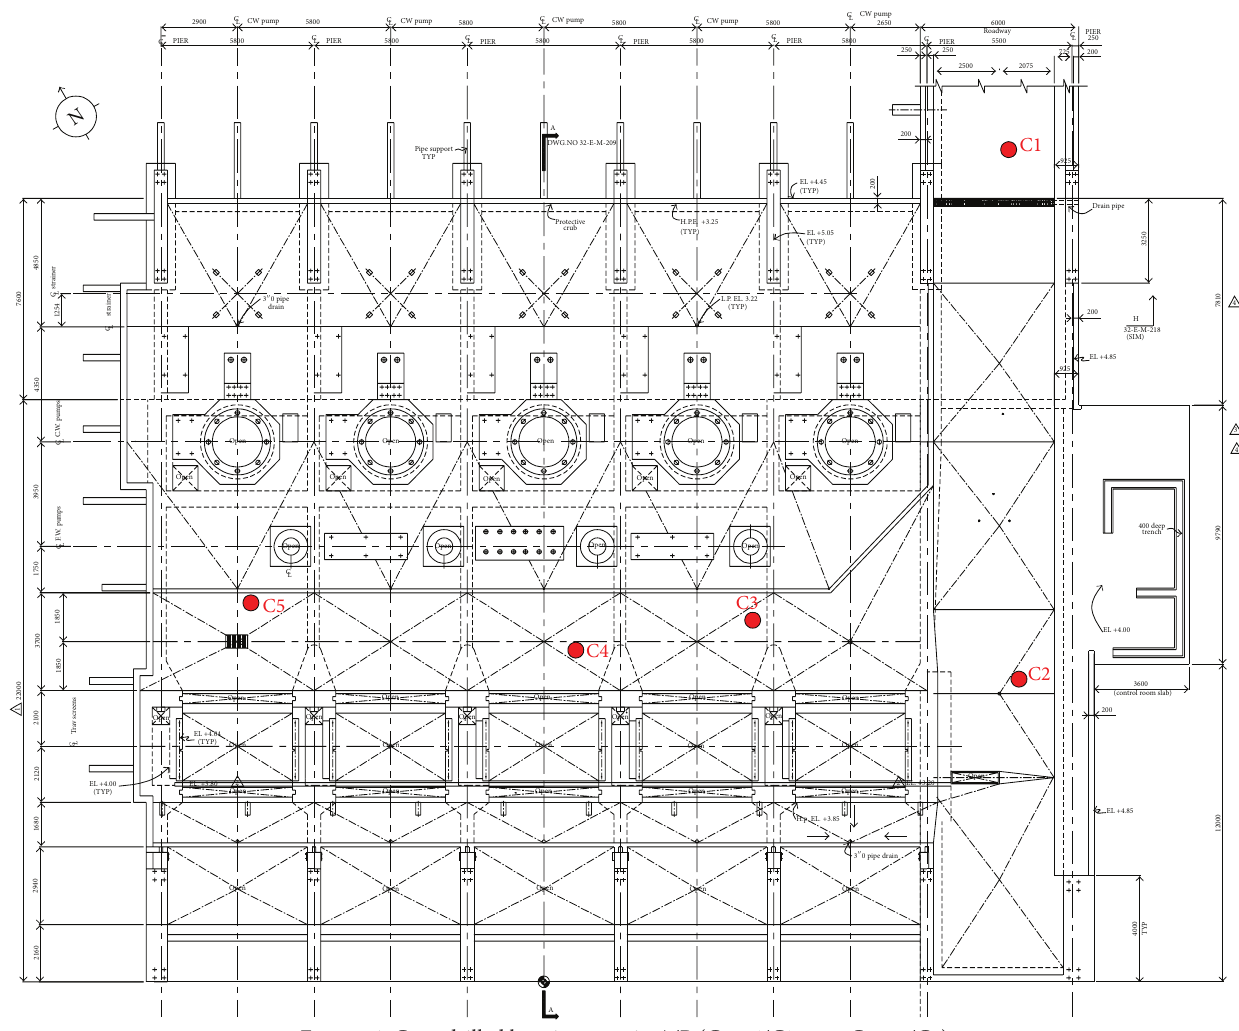
Figure 4: Core-drilled location at train A/B (Core 1/C1 up to Core 5/C5).